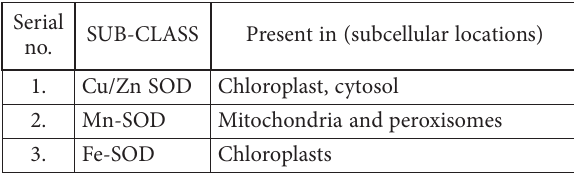
Table 3. Different sub classes of SOD and their locations Serial no.